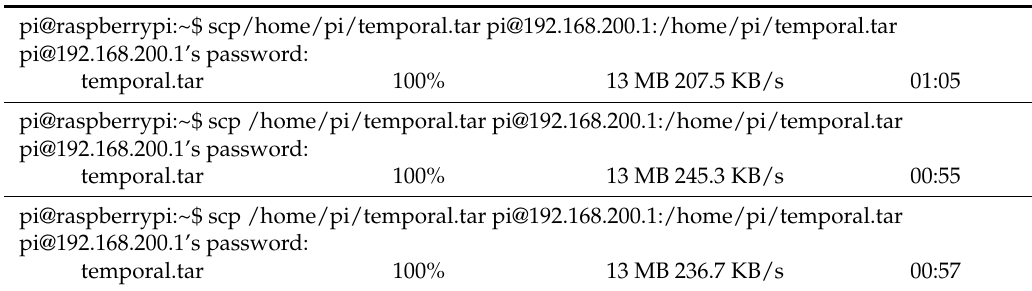
Table 7. Command line sequence for scp